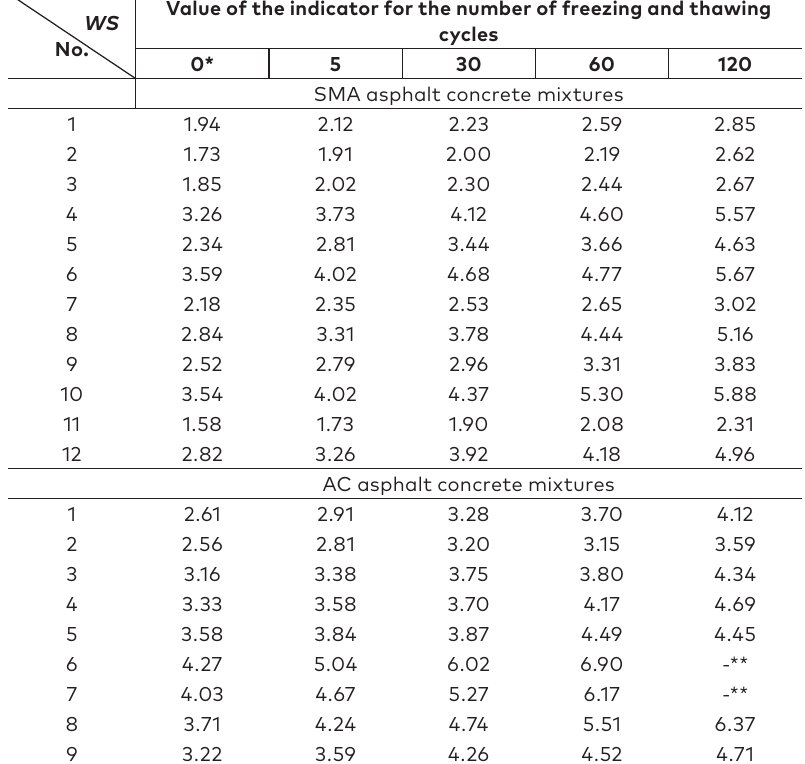
Table 4. The results of calculation of water saturation